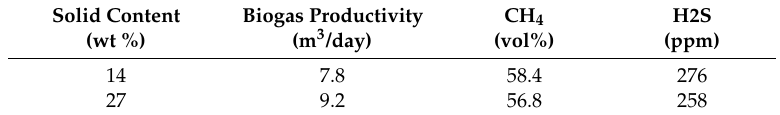
Table 2. Biogas production during wet- or dry-type AD of OFMSW in a continuous